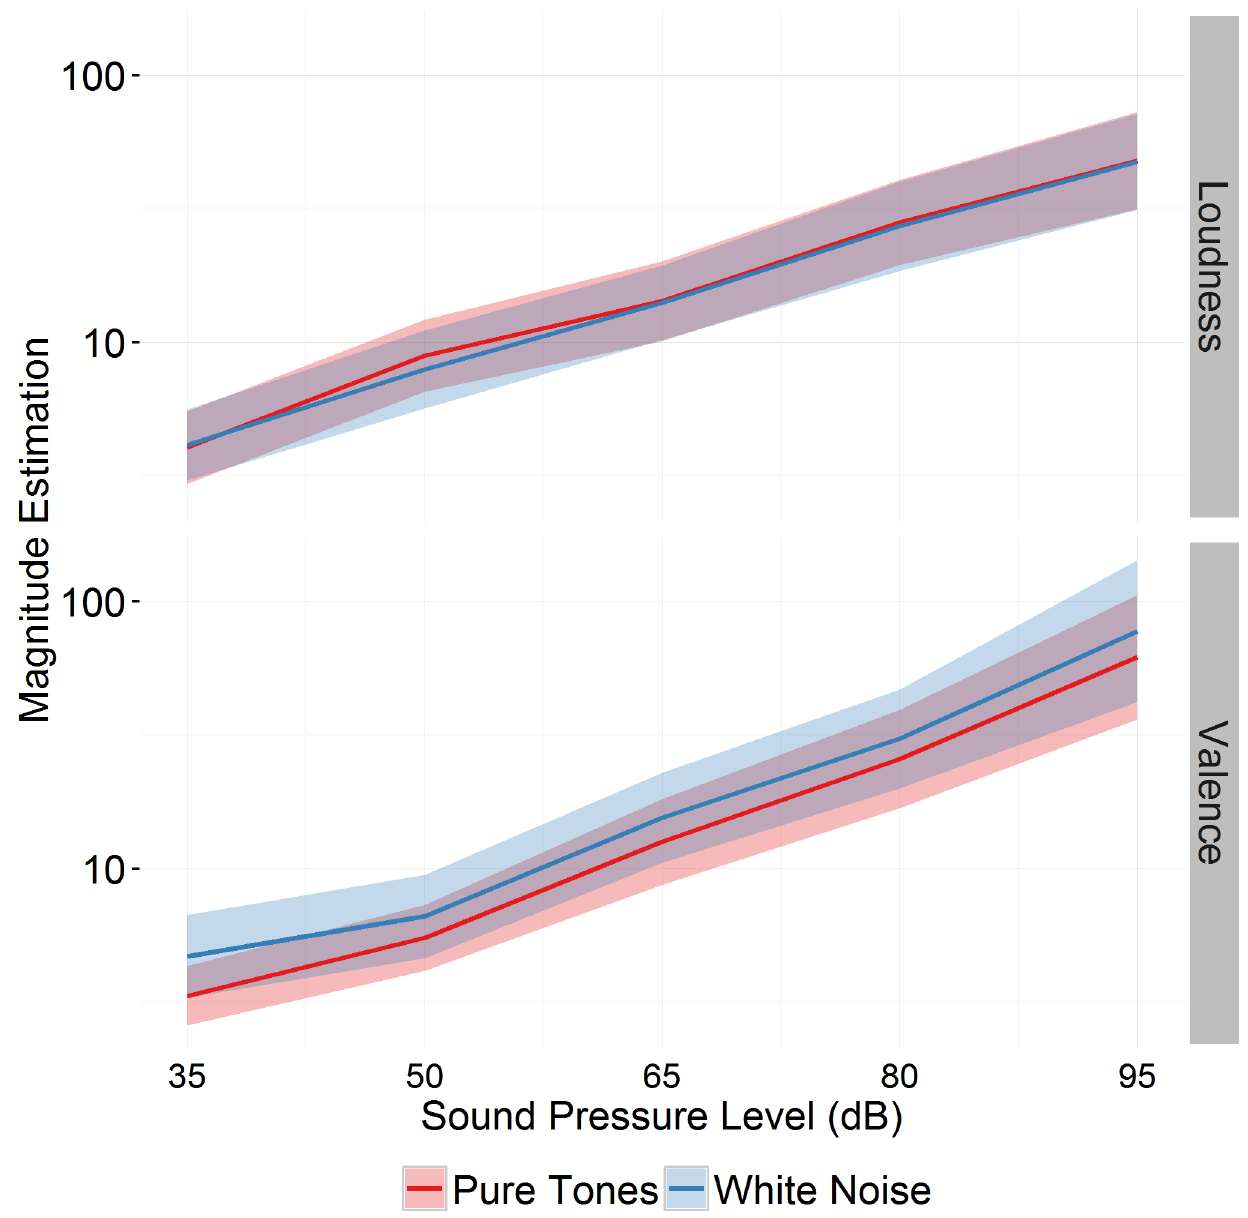
Fig 2. Magnitude estimation of loudness and valence of pure tones and white noise relative to a reference stimulus (65 dB SPL pure tone). Higher scores represent louder and more aversive perception. Relative loudness of sounds (as represented by the slope of the curves) did not differ between stimulus types. The ribbon represents standard errors. Data were available from 15